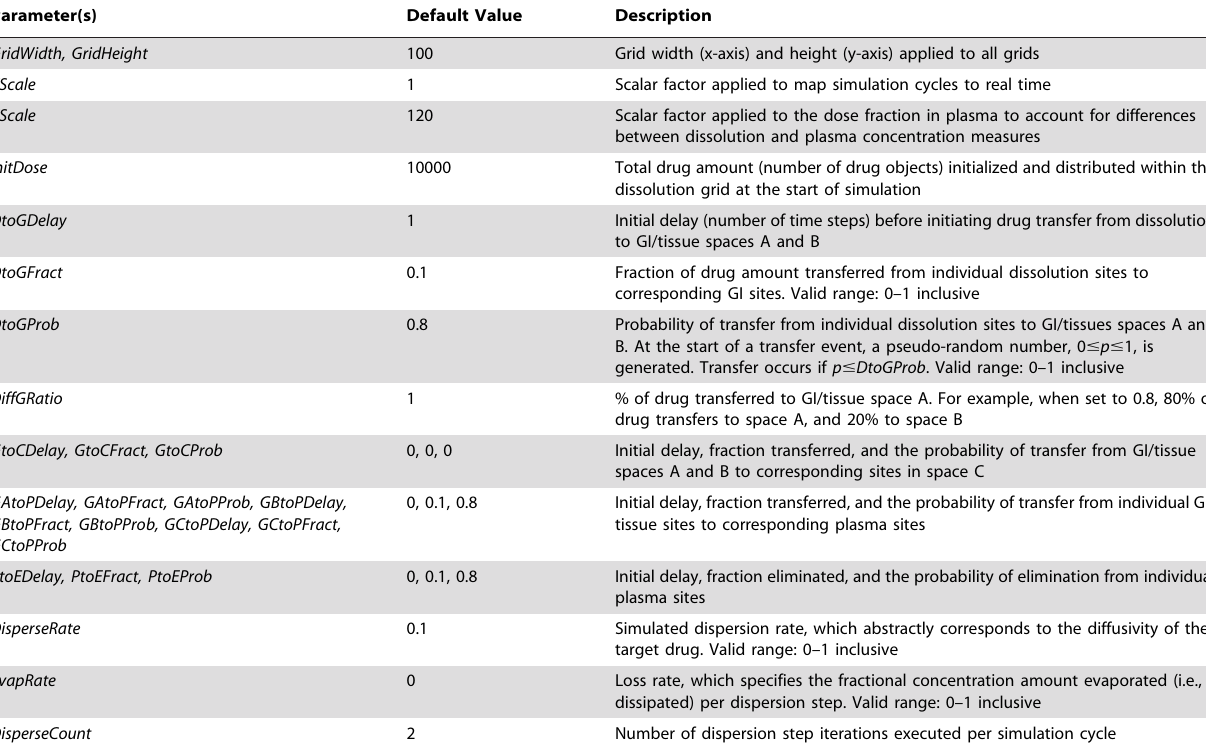
Table 1. In silico analog